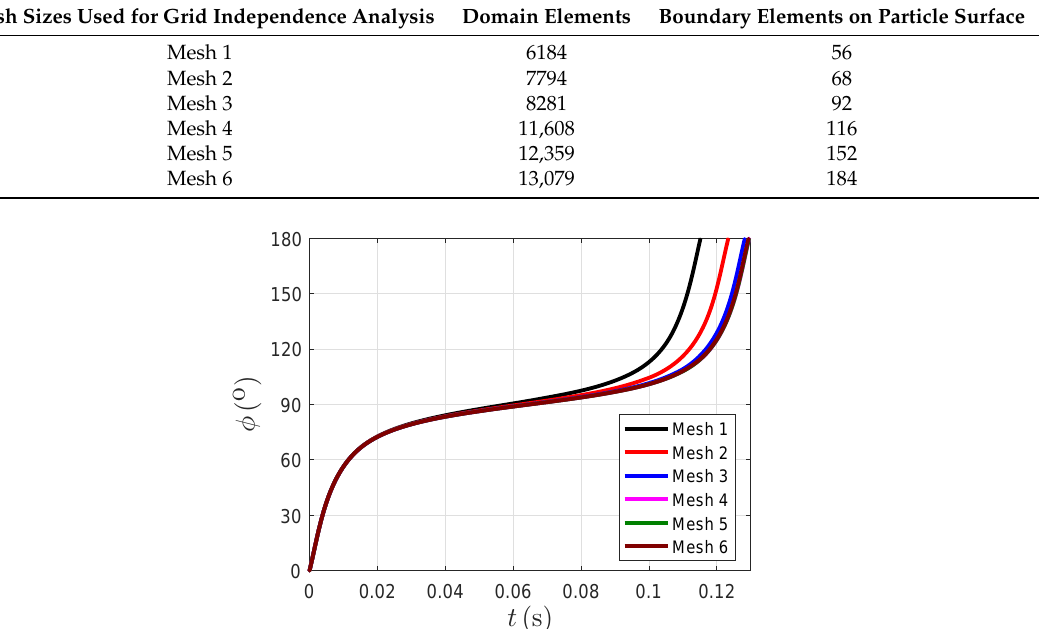
Figure 2. Grid independence analysis: particle orientation as a function of time, for AR = 4, y p 0 = 12 µ